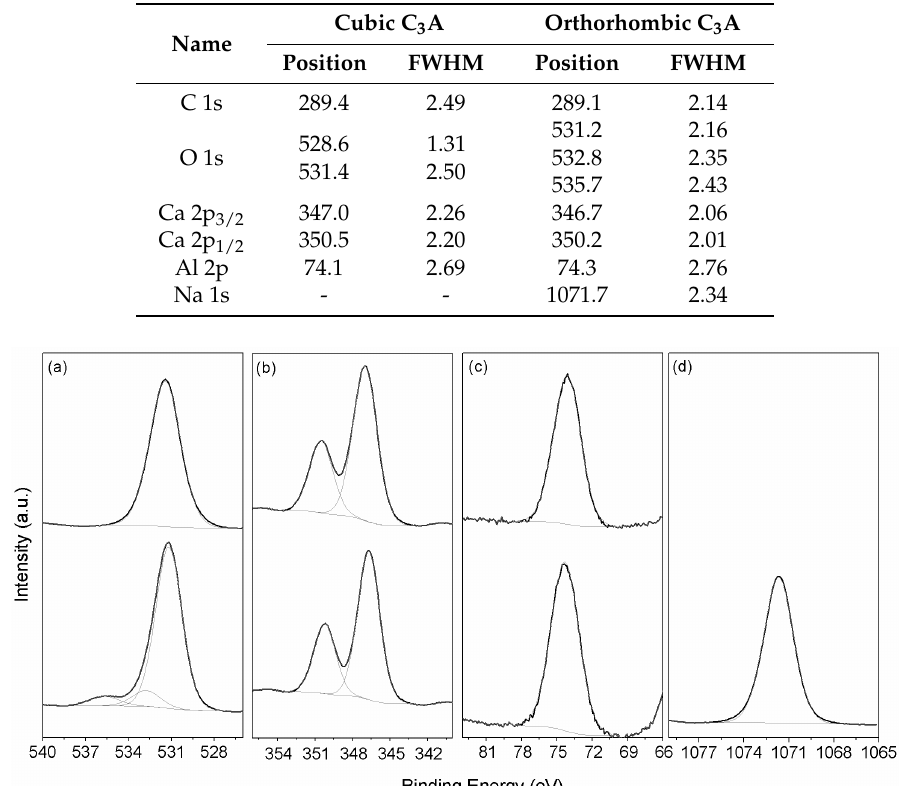
Table 2. Absorption fine structure and peak width (FWHM) for anhydrous cubic and orthorhombic C 3 A examined by XPS (X-ray Photoelectron Spectroscopy, eV).